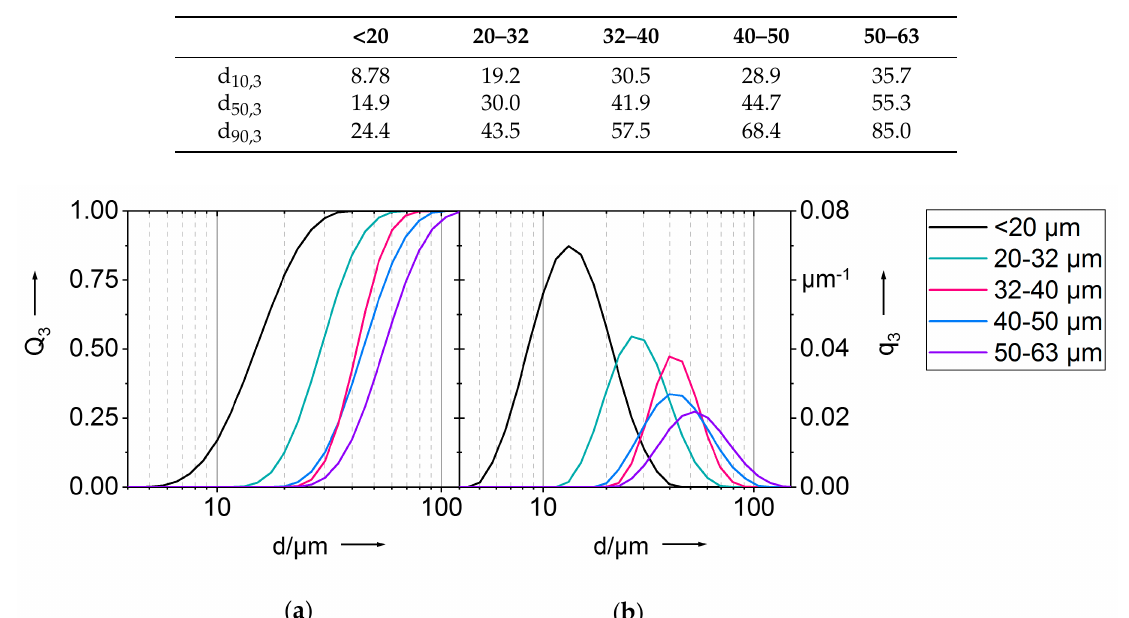
Figure A1. Particles size distributions (PSD) of sieved powder fractions according to ISO 9276-1 [96], 95 wt% Al, 5 wt% Cu; ( a ) cumulative particle weight fraction Q 3 ; ( b ) weight specific particle size distribution density q 3 .